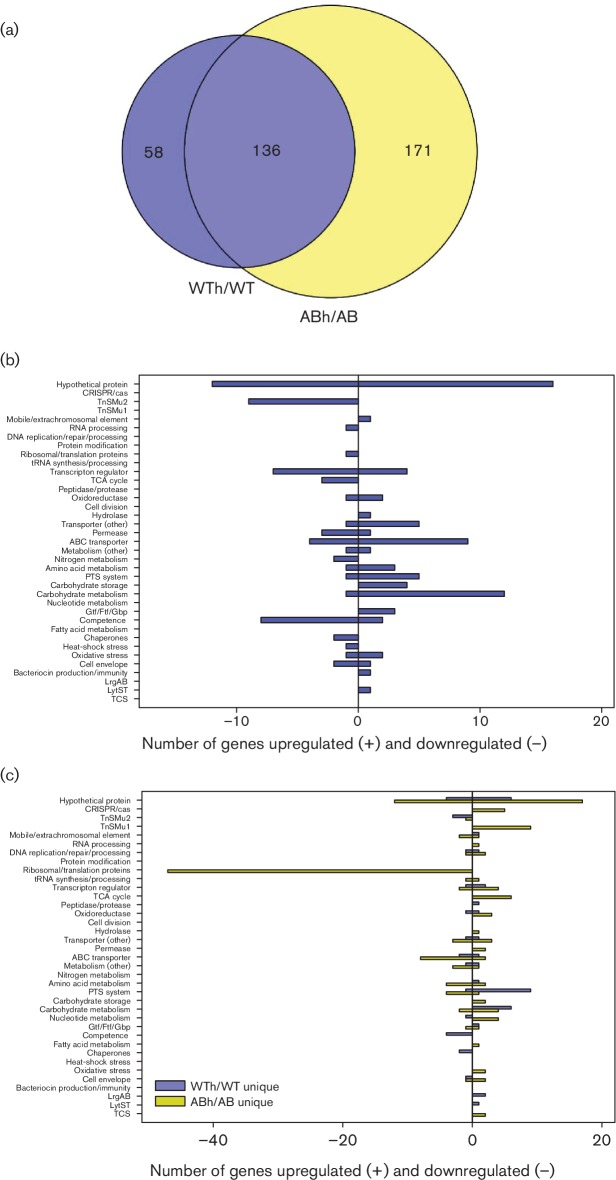
Comparison of wild-type and lrgAB mutant gene expression during heat stress growth. (a) Venn diagrams were used to identify overlapping and unique genes in WTh/WT and ABh/AB DE analyses (≥2.0-fold change and P<0.005). (b) Functional categorization of 136 overlapping genes between WTh/WT and ABh/AB DE analyses (≥2.0-fold change and P<0.005). (c) Functional categorization of 58 and 171 genes unique to WTh/WT (blue bars) and ABh/AB (yellow bars) DE analyses, respectively (≥2.0-fold change and P<0.005). For (b) and (c), functional categories were assigned using genomic functional annotations as well as those found in the DAVID and PATRIC databases. Upregulated genes in each category are found to the right of the y-axis (positive numbers), and downregulated genes are found to the left of the y-axis (negative numbers).